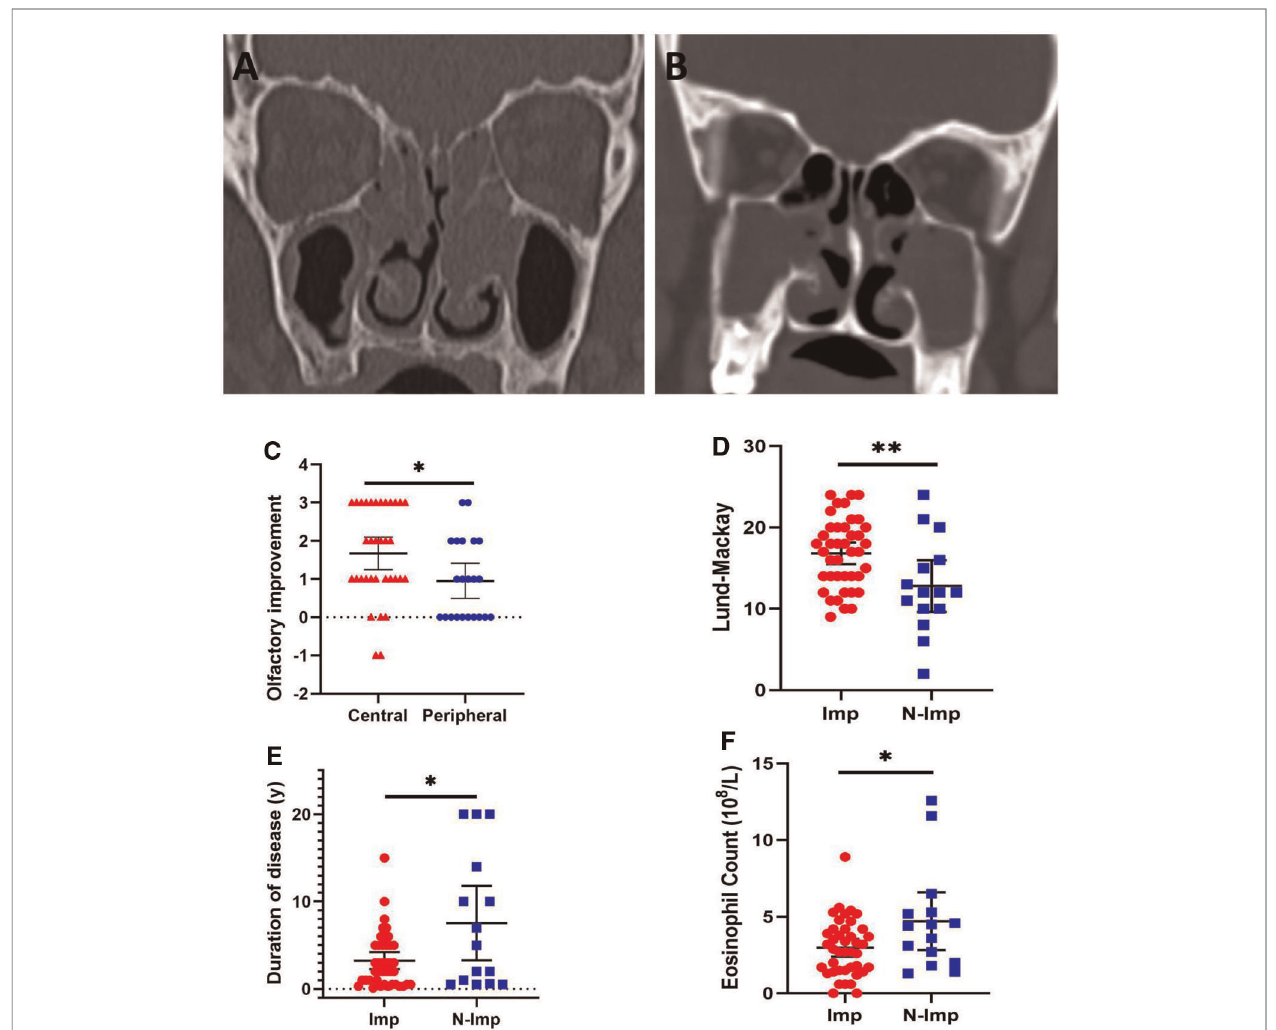
FIGURE 3 | Representative computed tomography imaging of central type ( A ) and peripheral type ( B ) opaci fi cation. The central type showed higher olfactory improvement scores compared to the peripheral type ( C ). Nonimproved patients (N-Imp) exhibited lower Lund – Mackay scores ( D ), longer duration of olfactory dysfunction ( E ), and higher circulating eosinophil count ( F ) compared with improved patients (Imp). * P <0.05, ** P <0.01.